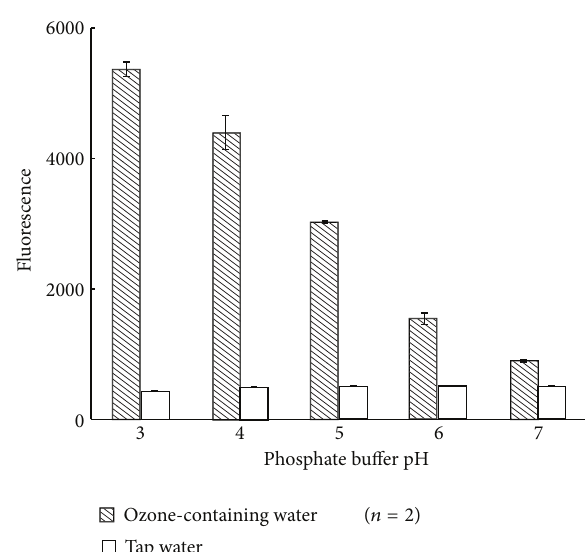
Figure 2: Effect of phosphate buffer pH on fluorescence intensity.